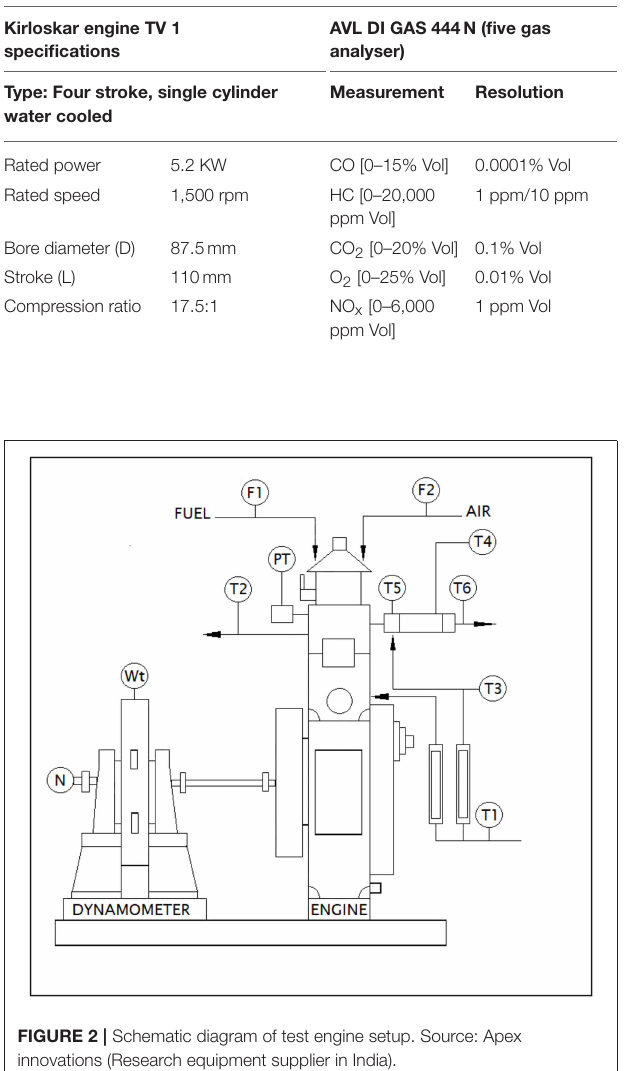
TABLE 4 | Blend factor and Ester factor for various blend and ester